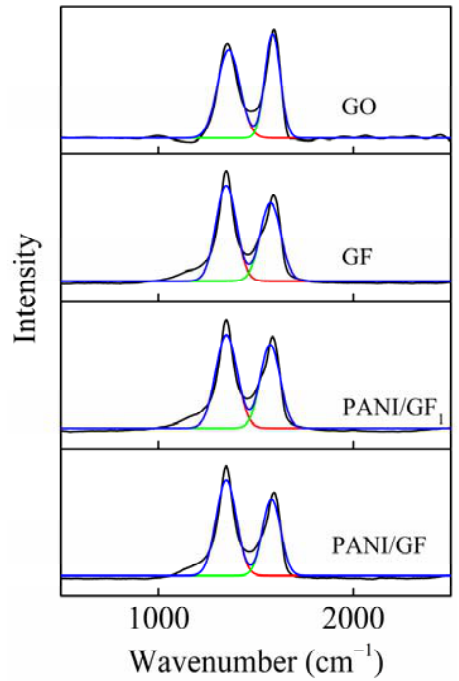
Figure 5. Raman spectra of GO, GF, PANI/GF 1 and PANI/GF.